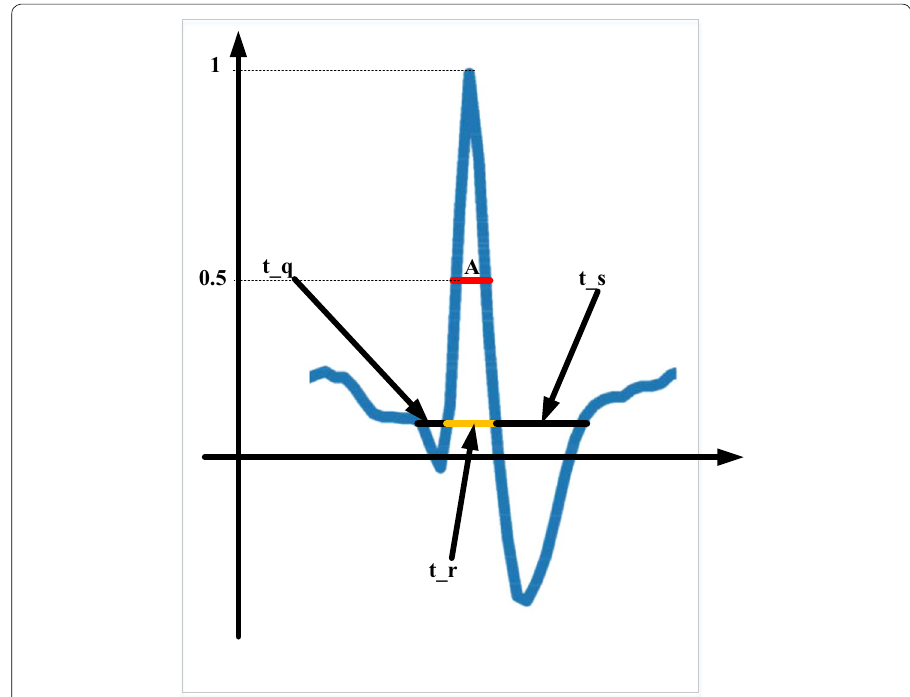
Fig. 5 QRS summits periods